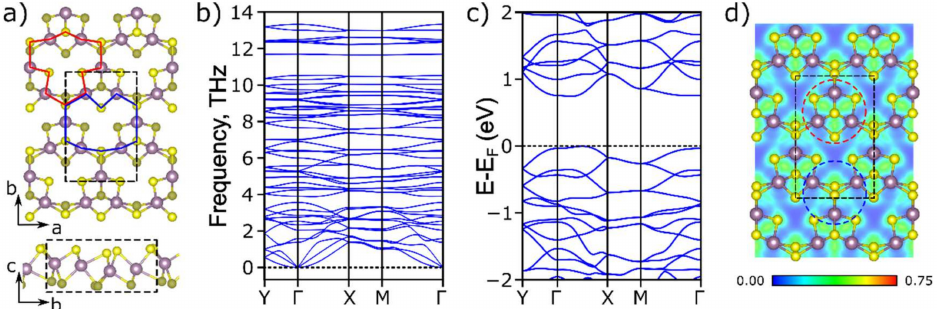
Figure 1. ( a ) Atomic structure, ( b ) phonon dispersion spectra, ( c ) electronic band structure, and ( d ) electron localization function for the total electron density along the ab plane for A’-MoS 2 . The unit cell is indicated by black dashed lines. Mo and S atoms are depicted in purple and yellow colors, respectively. Two types of pores in the A’-MoS 2 structure are marked by red and blue areas in ( a